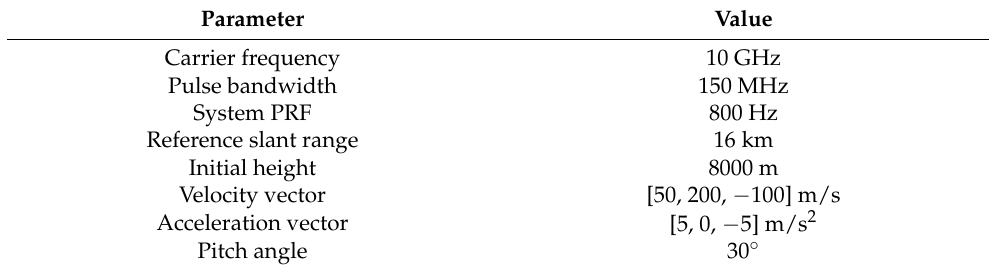
Table 1. Simulation parameters.